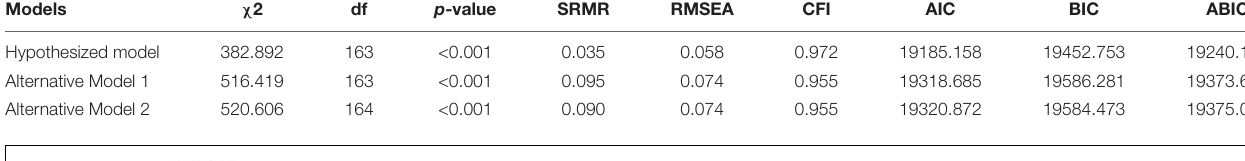
TABLE 5 | Model fit comparisons among the hypothesized and alternative models.